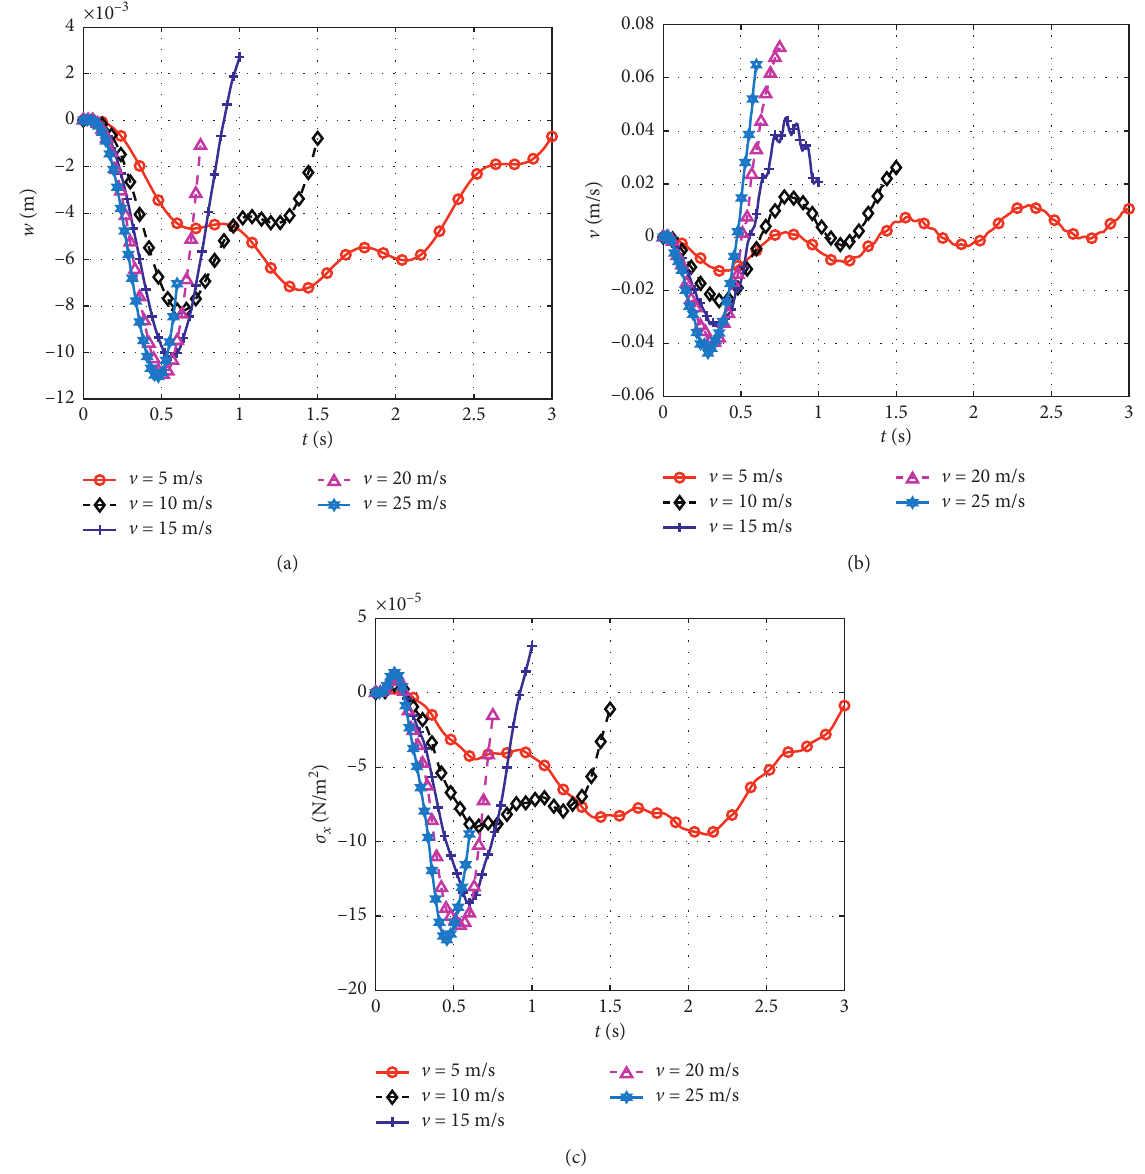
Figure 8: Dynamic deflections of the central point of the plate versus time for different velocities v (m/s). (a) Deflection w versus time, (b) velocity v versus time, and (c) stress σ x versus time.